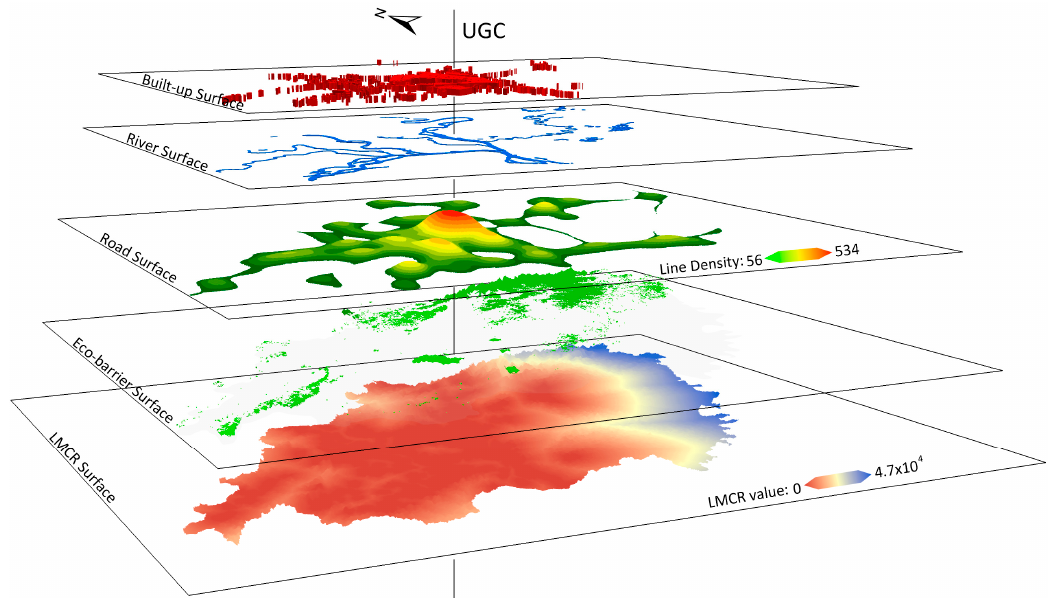
Table 3. Suitability zoning and corresponding basic information.